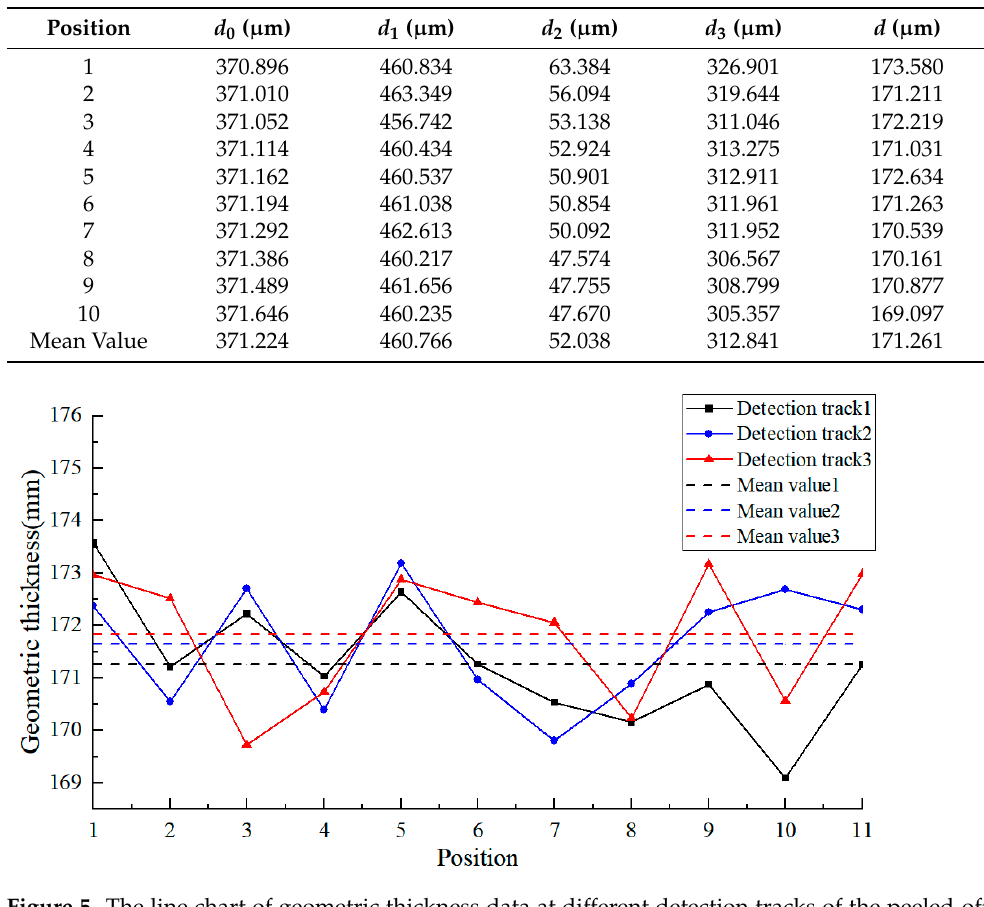
Figure 5. The line chart of geometric thickness data at different detection tracks of the peeled-off self-lubricating fabric liner.